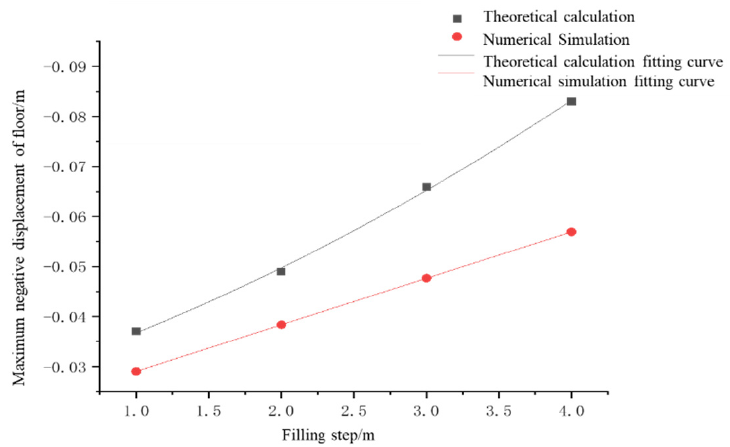
Figure 13. The relationship curve between different filling steps and the maximum negative displacement of the floor.